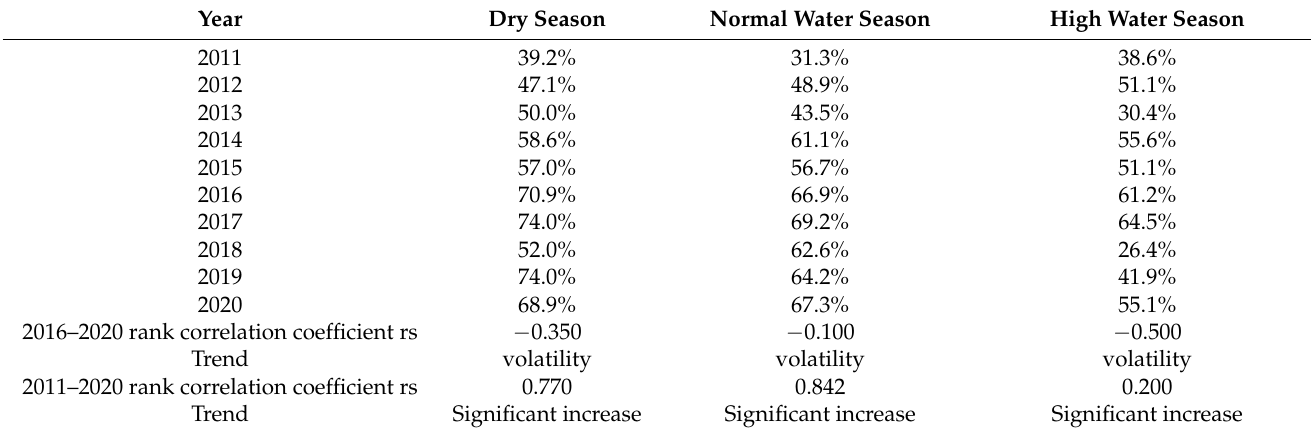
Table 1. 2011–2020 Proportion and change trend of water quality grades I–III in different water stages of rivers in Heilongjiang